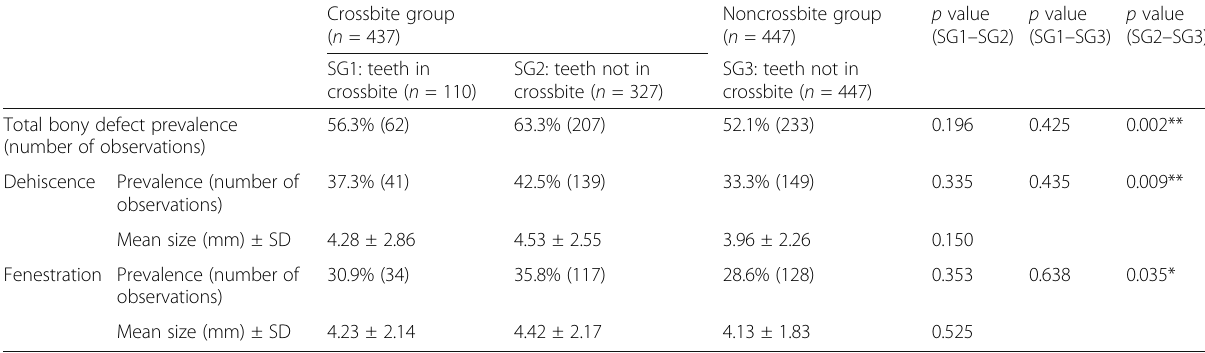
Table 5 Prevalence and mean size of total bony defects, dehiscence, and fenestration by subgroup